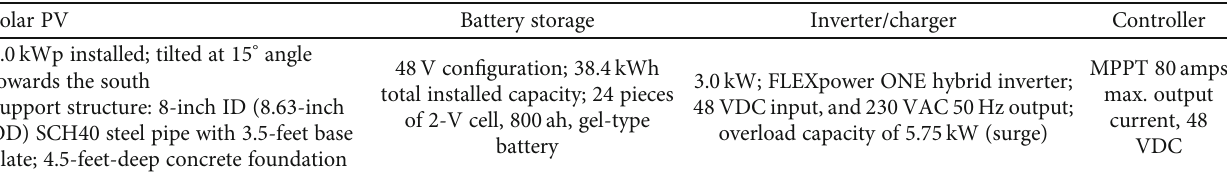
Table 2: Speci fi cations of the standalone solar PV installations at the CHPS compounds. Solar